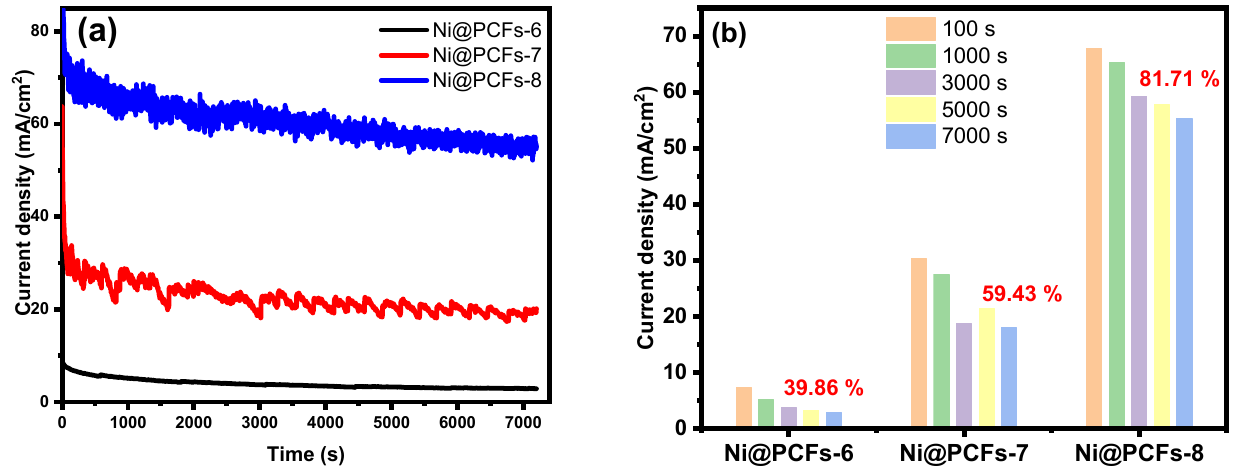
Figure 8. ( a ) Chronoamperograms of the Ni@PCFs-6, Ni@PCFs-7, and Ni@PCFs-8 electrocatalysts at a potential value of 0.7 V in (0.5 M methanol + 1.0 M KOH) solution for 7200 s. ( b ) Percentage of current density at different times. Table 2. Comparison of the current density of differnt nickel-based catalysts supported on carbon materials.